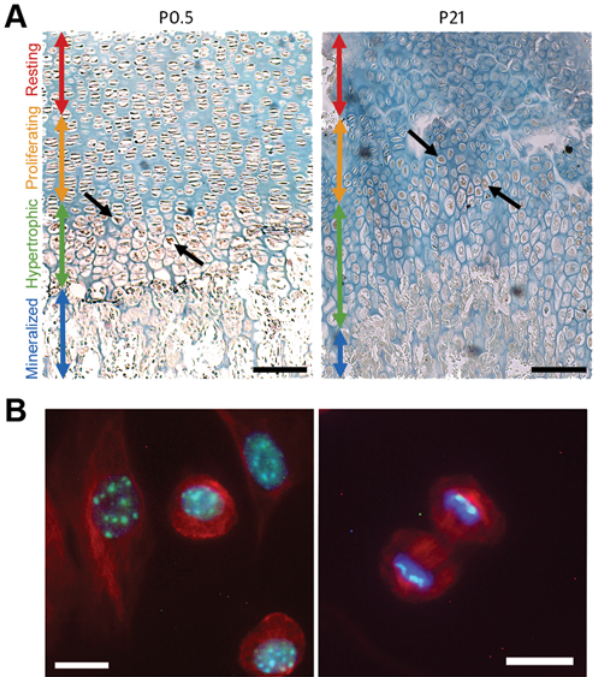
Figure 1. Expression and localization of ATRX in growth plate chondrocytes. (A) Immunostaining of ATRX in humerus growth plates of P0.5 and P21 mice. ATRX is seen in the nuclei of resting, proliferating and early hypertrophic cells in the growth plates (arrows). Scale bar: 100 m m. Regions of the growth plate are identified as resting (red arrow), proliferating (yellow), hypertrophic (green) and mineralized (blue). (B) Immunofluorescence detection of ATRX in primary mouse chondro- cytes isolated from E15.5 long bones. Merged image of ATRX (green), DAPI (blue) and alpha-tubulin (red) reveals a punctate ATRX staining pattern restricted to the nucleus during interphase (left panel) and specific localization to condensed chromatin during mitosis (right panel). Scale bar: 10 m